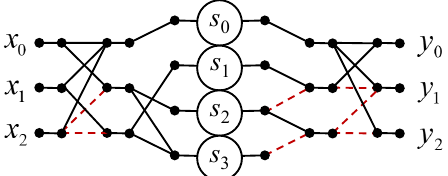
Figure 2. Algorithmic structure of the processing core for the computation of the 3-point circular